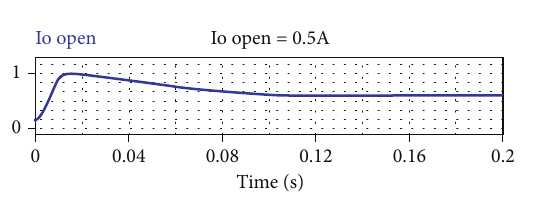
Figure 13: Output current I